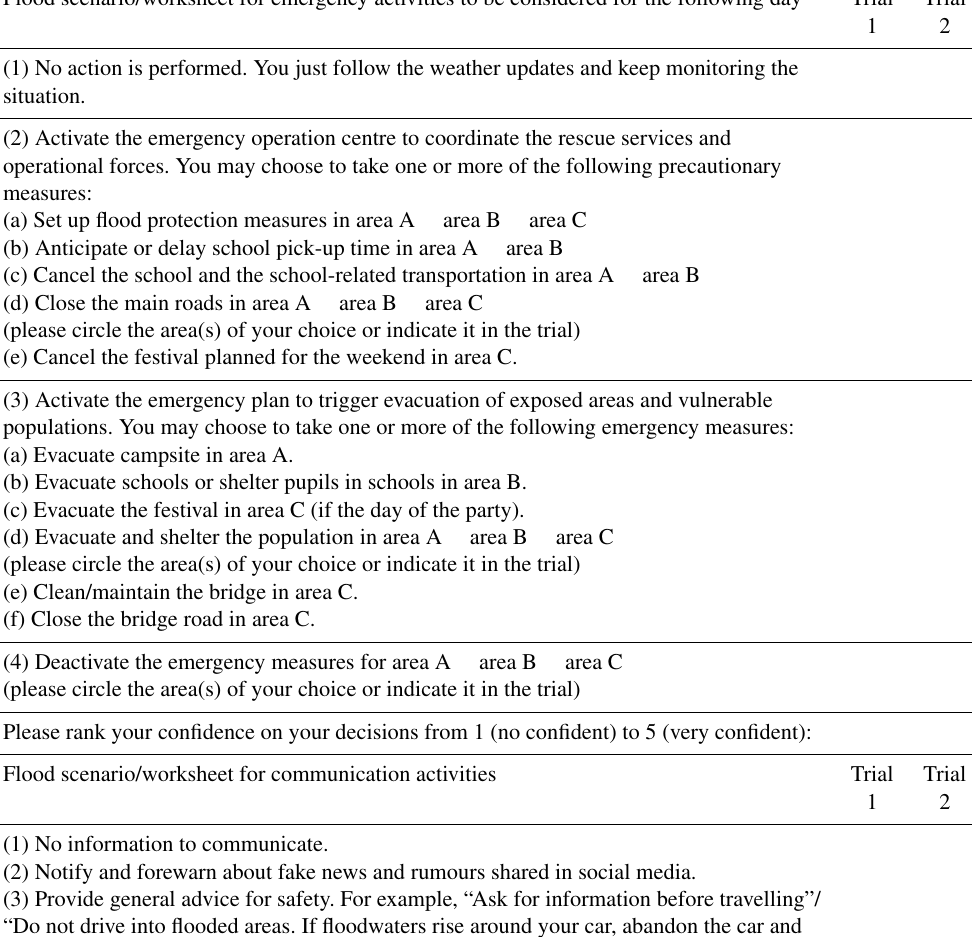
Table A1. Worksheet with predefined list of emergency and communication activities delivered to players of the flood scenario. Flood scenario/worksheet for emergency activities to be considered for the following day Trial Trial